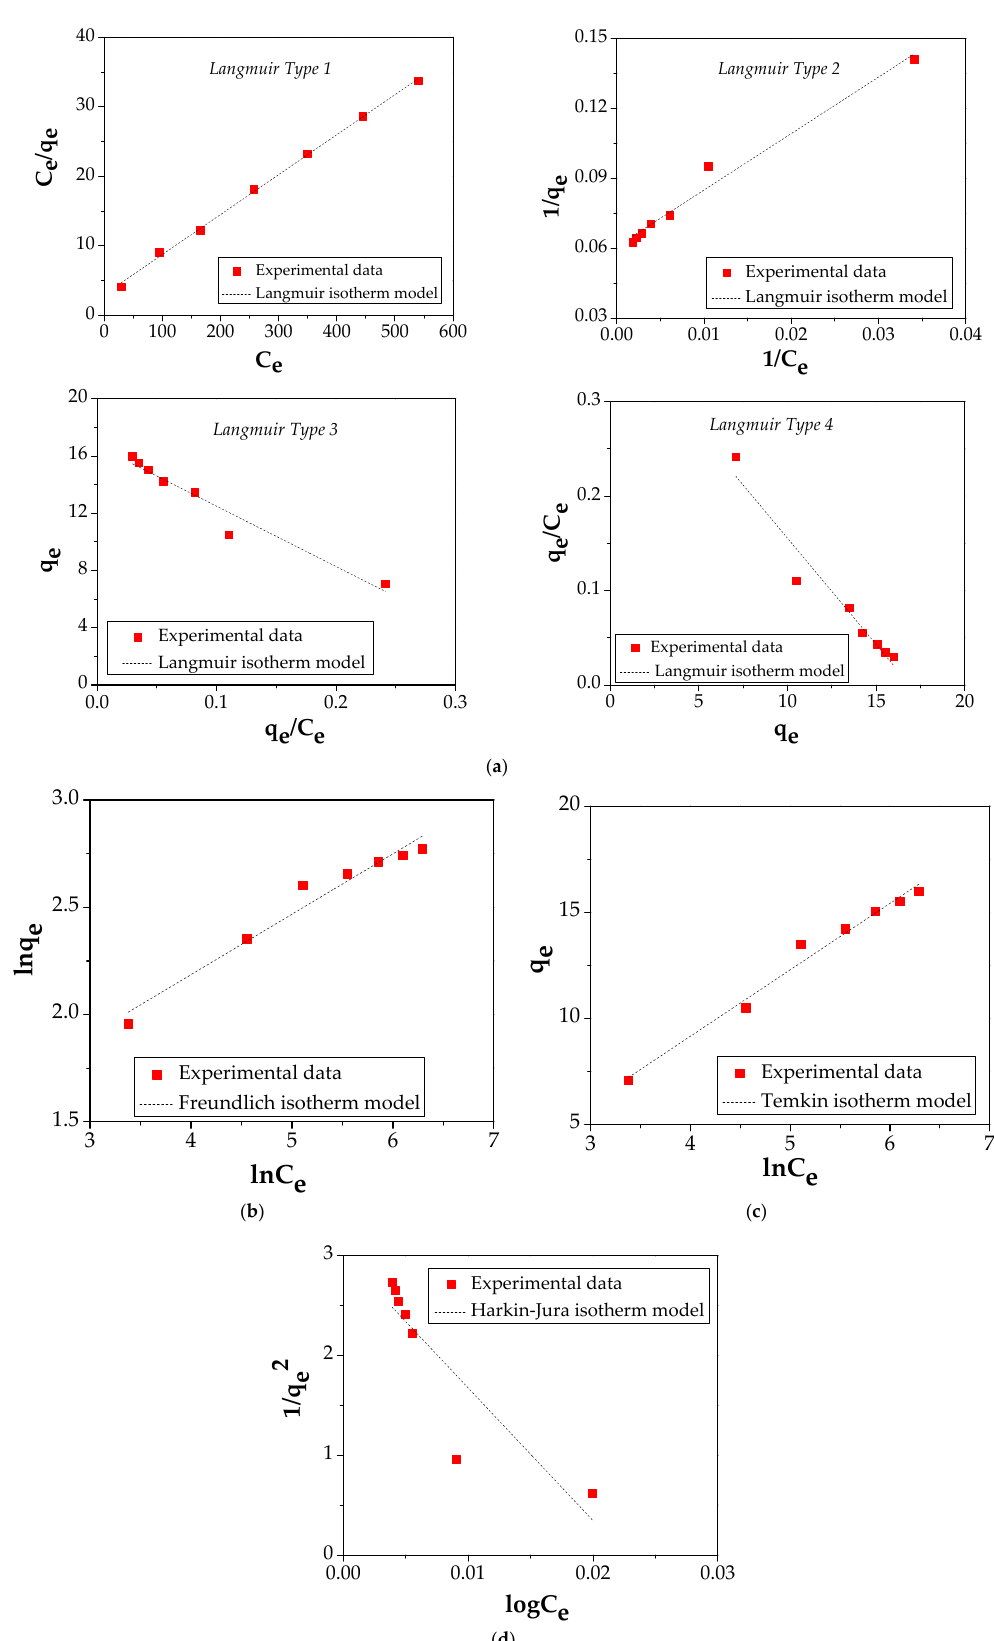
Figure 10. ( a ) Langmuir isotherm plot; ( b ) Freundlich isotherm plot; ( c ) Temkin isotherm plot; ( d ) Harkins–Jura isotherm plot . The correlated parameters of both equations are shown in Table 3. It should be mentioned that the value of experimentally obtained q max is 15.991 mg/g. Table 3. The correlated parameters of isotherms of Cu (II) adsorption onto FA/Fe 3 O 4. Model